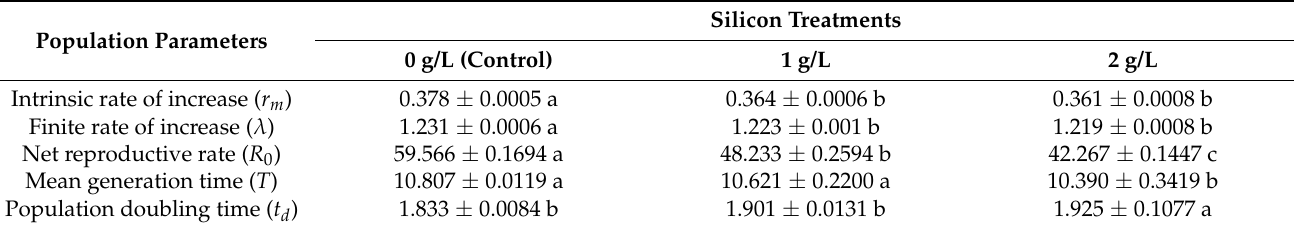
Table 2. Life table parameters of S. avenae on different silicon-treated wheats.